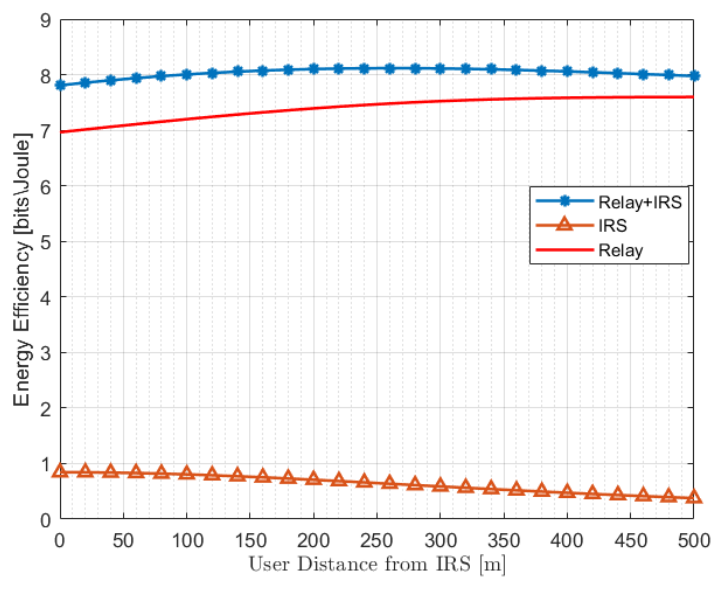
Figure 3. EE versus User